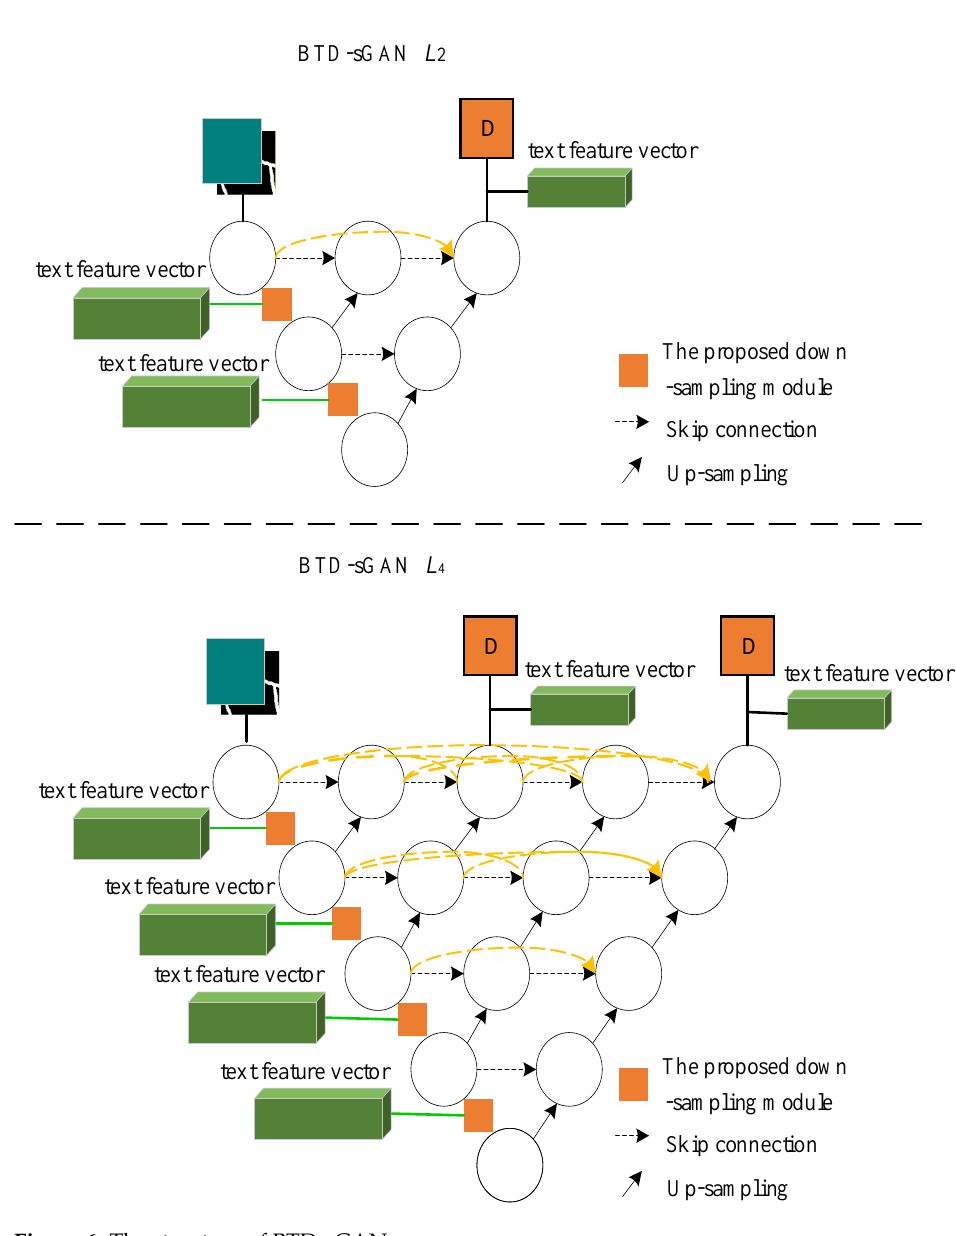
Figure 6. The structure of